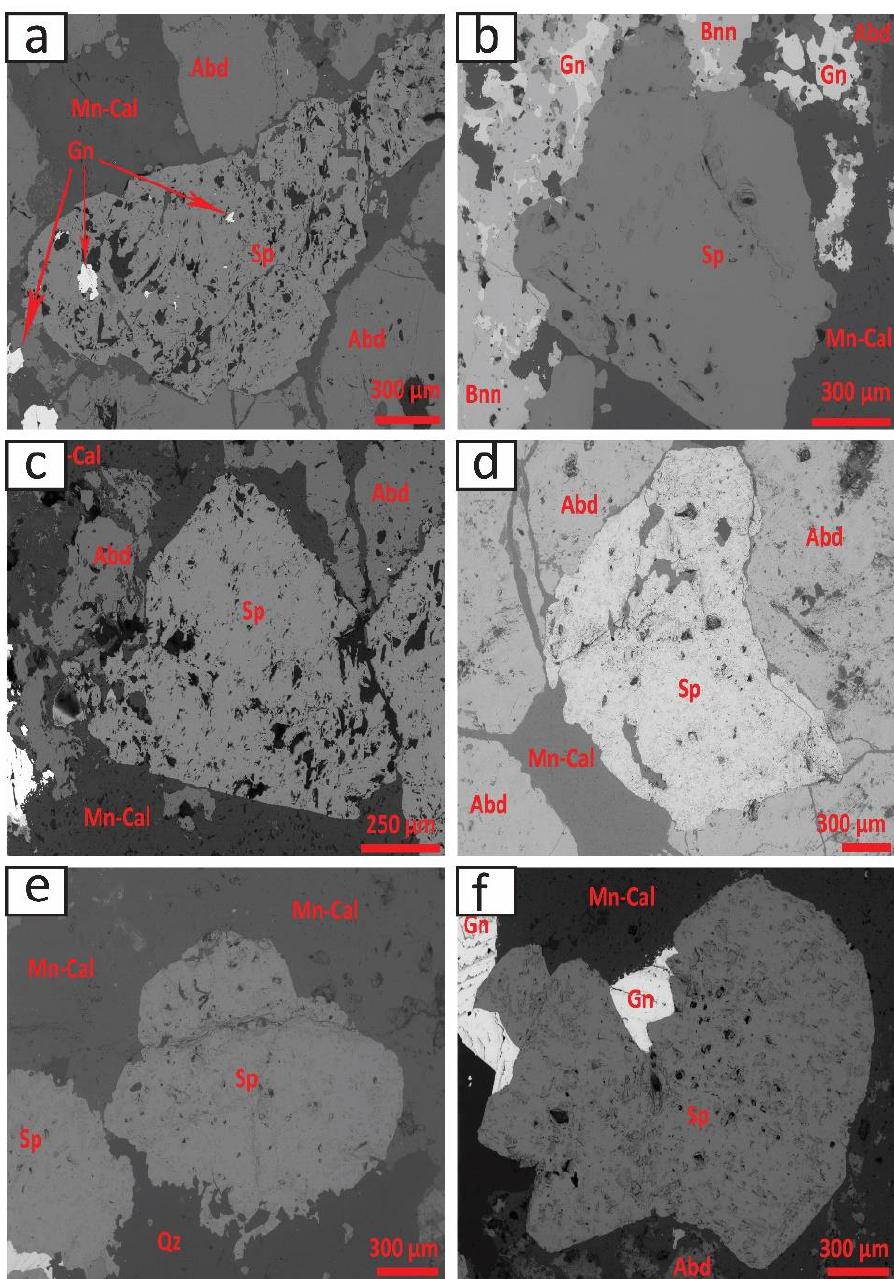
Figure 3. SEM backscattered images of sphalerite (Sp), where: ( a , b ) stage III sphalerite associated with galena (Gn) and bournonite (Bnn); ( c , d ) stage II sphalerite in association with alabandite (Abd); ( e , f ) stage I sphalerite in Mn-rich calcite (Mn-Cal) and quartz (Qz) veins, in association with galena.